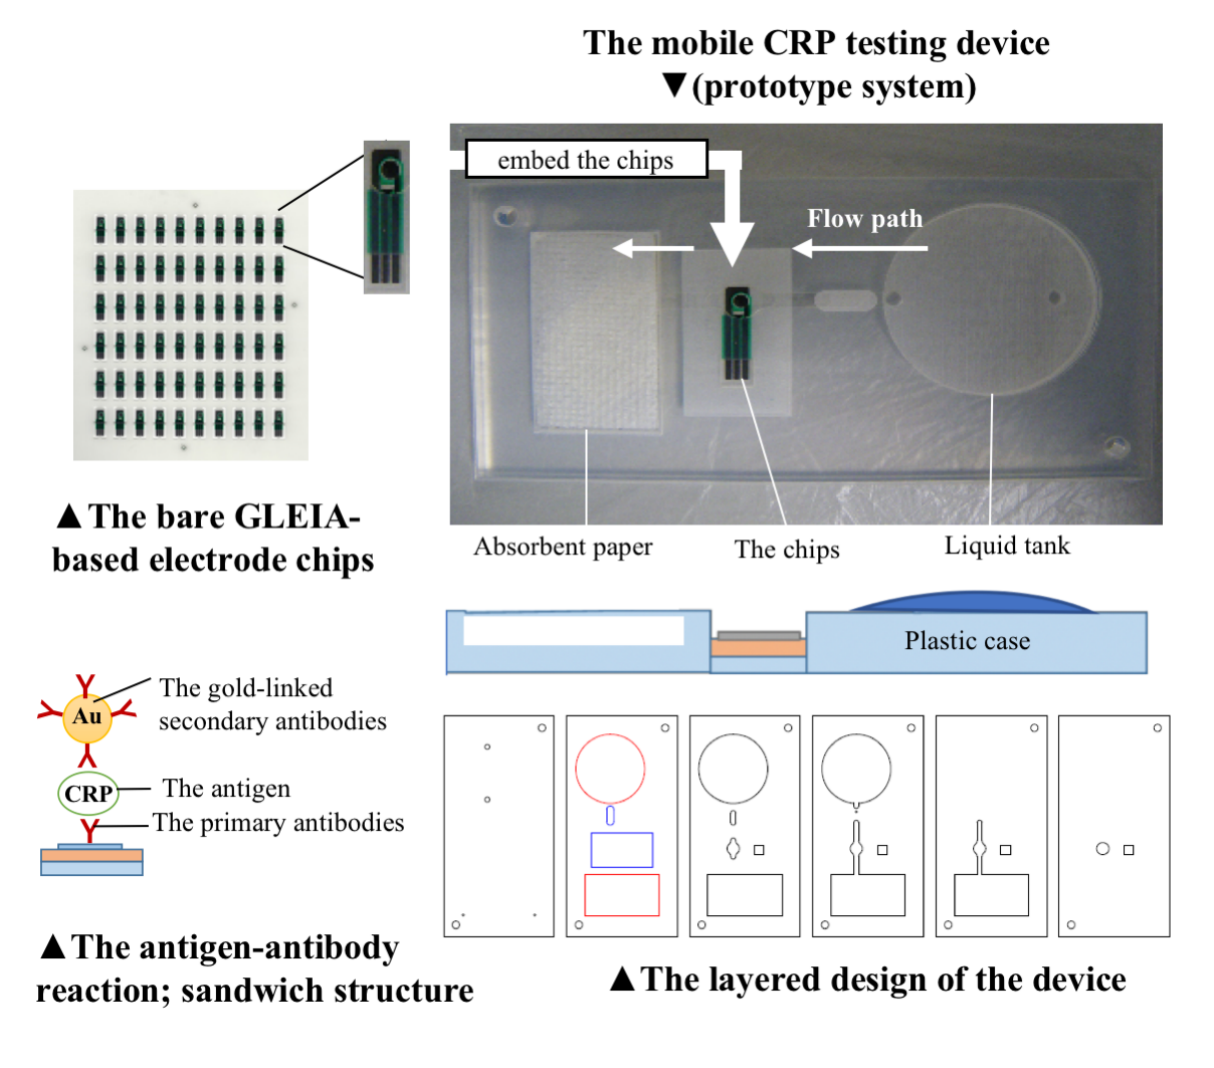
Figure 2. Production process from the chips to the prototype and the schematic of GLEIA measurement. CRP: c-reactive protein; GLEIA: gold-linked electrochemical immunosorbent